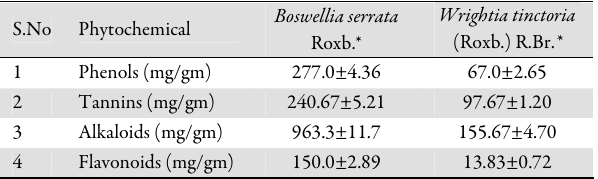
Tab. 2. Quantitative screening of phytochemicals (phenols, tannins,